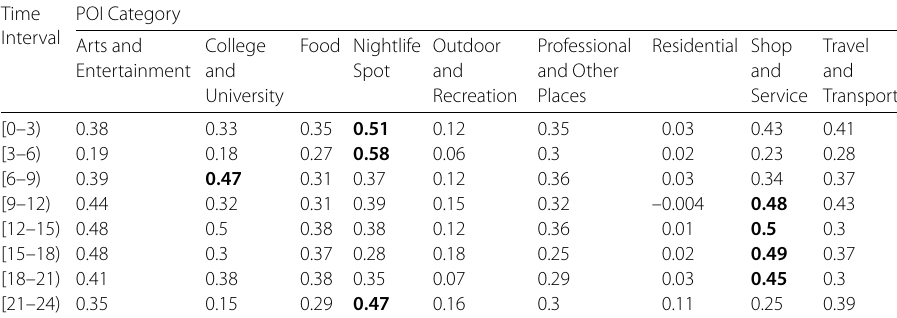
Table 2 Spearman’s rank correlation coefficients between theft and POIs at different time intervals Time POI Interval